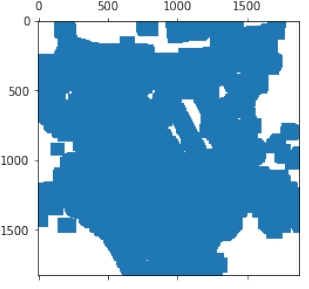
Figure 7. Observation rater maps for equal time intervals It is the Cartesian product of R × T that results in the complete spatio-temporal tensor grid X ∈ R ( t × m × n ) as shown in Fig- ure 8, where every cell on the tensor X , ( c, i, j ) , has a distinct measurement.